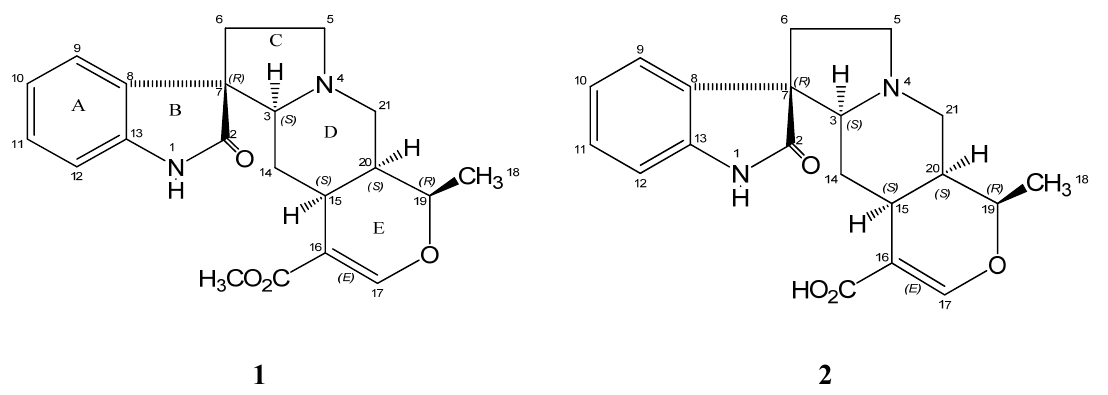
Figure 1. Structures of alkaloids 1 and 2